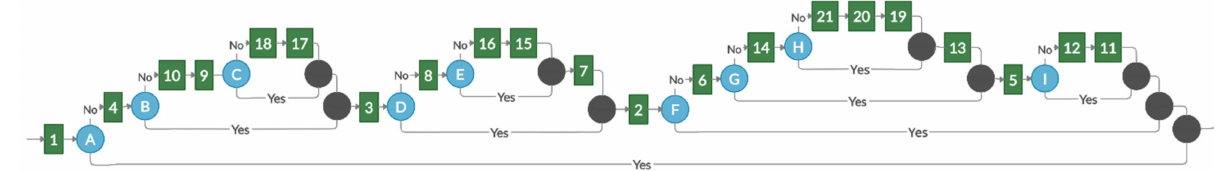
Figure 4. Result of TBCG transformation for competence tree, presented in Figure